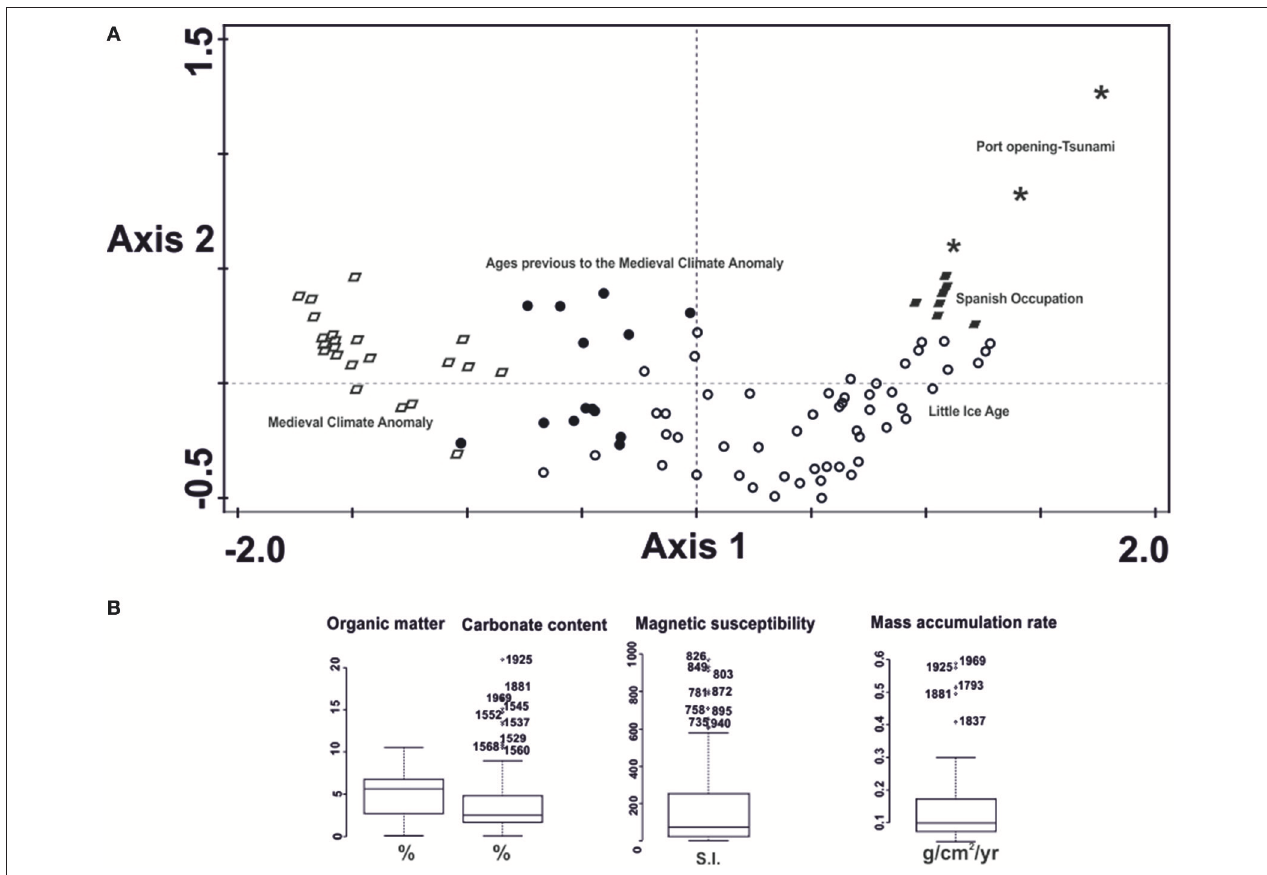
FIGURE 6 | (A) Non-metric multidimensional scaling ordination of Organic matter, Carbonate content, Magnetic susceptibility and Mass Accumulation Rate by ages. The different symbols represent ordination scores. They represent ages in calibrated years AD. Ages in black open circles correspond with the Little Ice Age; in black circles to ages previous to the MCA; in open black rhomboids to the Medieval Climate Anomaly; in filled black rhomboids to the Spanish Occupation and in asterisks to the Manzanillo port opening and the tsunami of 1932. (B) Box and whiskers plots showing extreme values for Organic matter, Carbonate Content, Magnetic susceptibility and Mass Accumulation